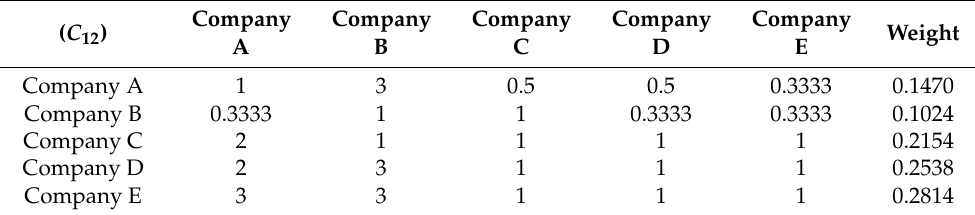
Table 11. Weights of the five alternatives calculated using the pairwise comparison matrix for subcriterion C 12 .